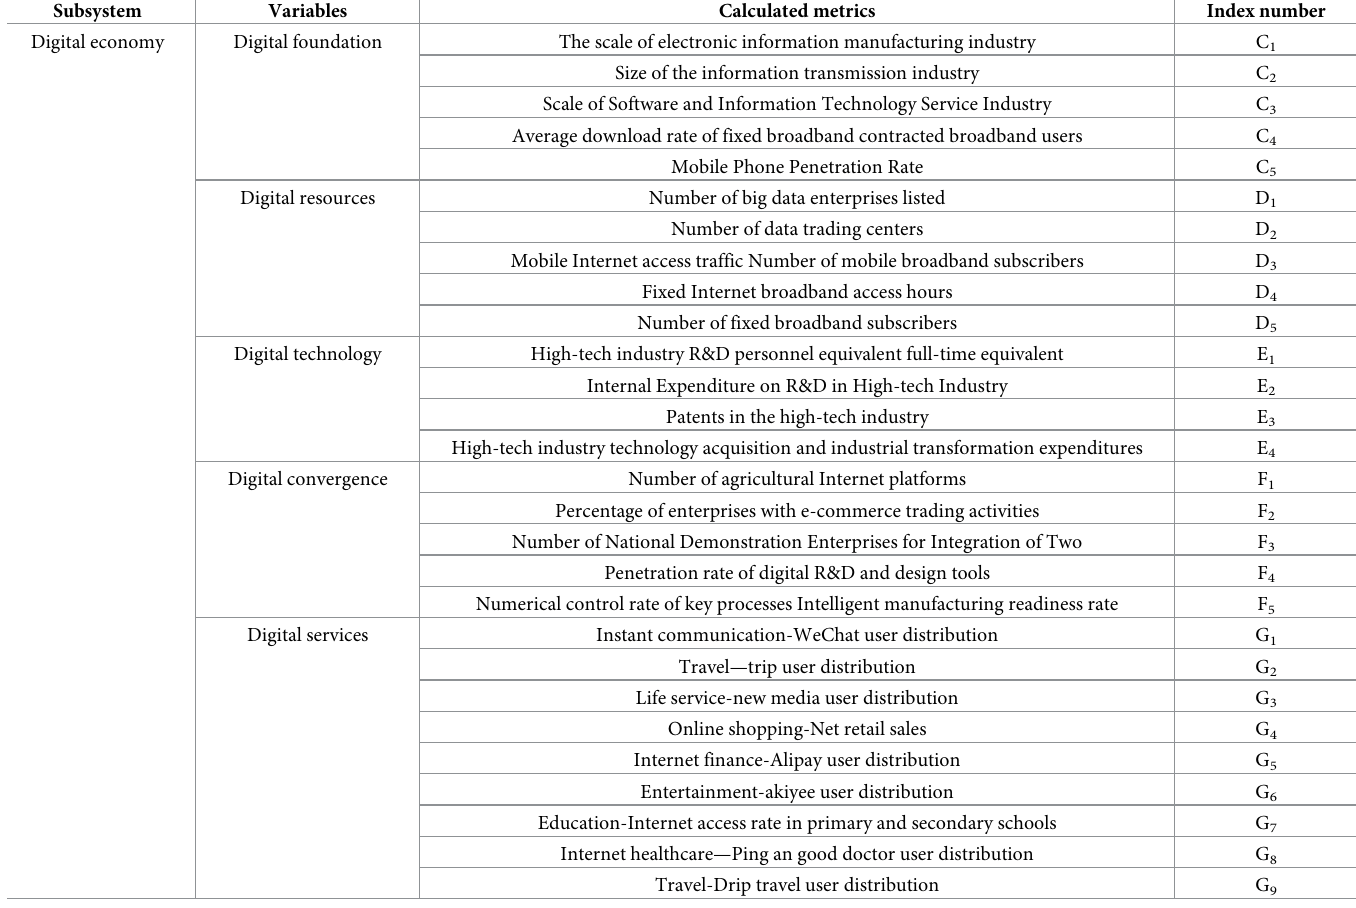
Table 2. Evaluation index system for digital economy